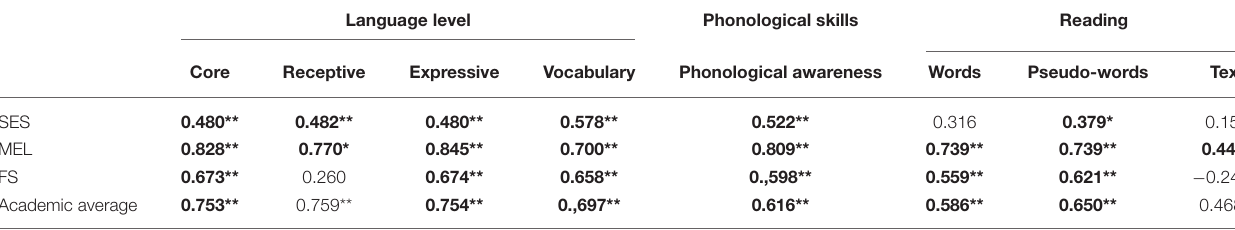
TABLE 6 | Correlation matrix: socioeconomic, family and linguistic variables.